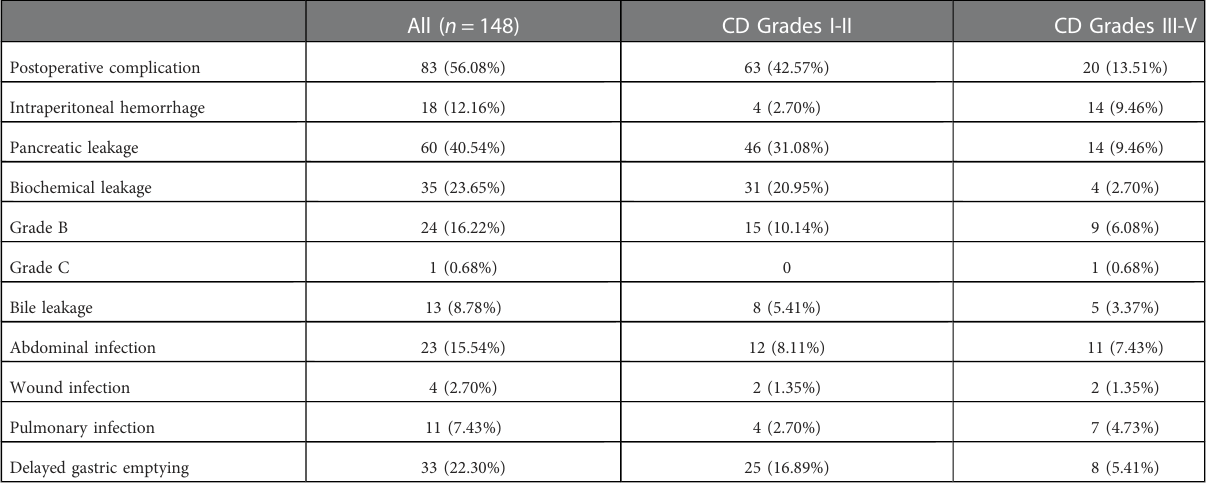
TABLE 2 Postoperative complications.